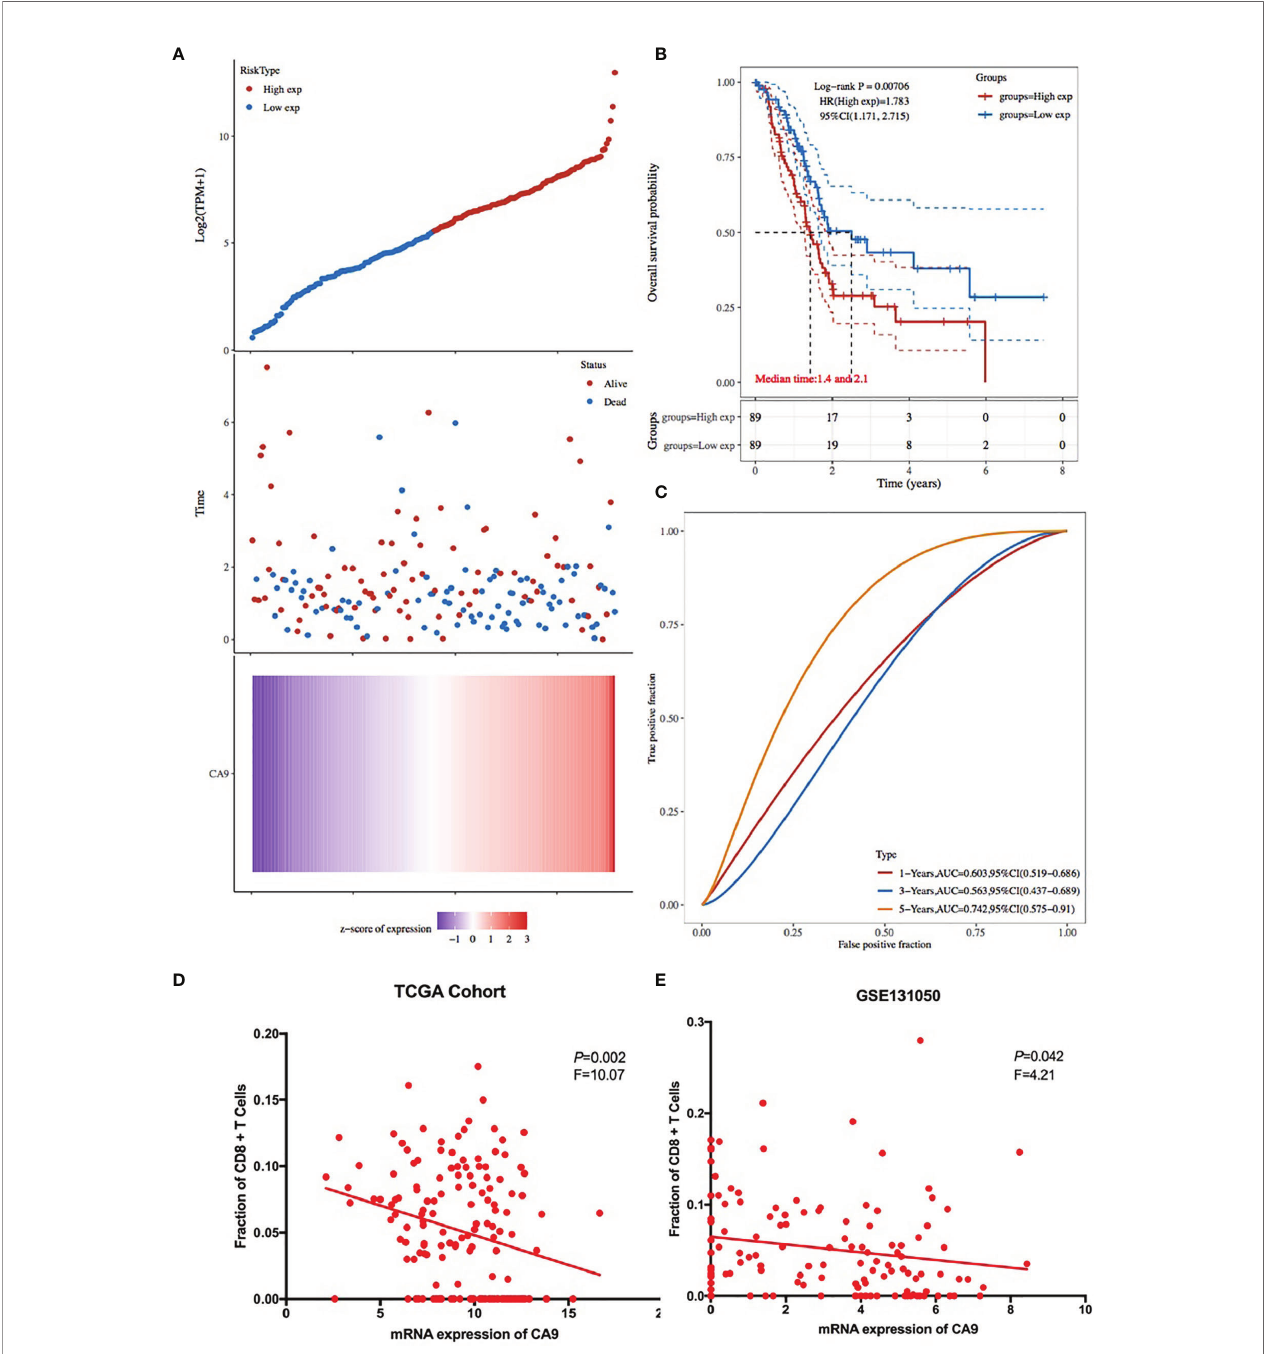
FIGURE 3 | Prognostic value of CA9 and its association with CD8+ T cells in fi ltration from TCGA and GEO pancreatic cancer dataset. (A) Risk score plot and heatmap of CA9 among TCGA pancreatic cancer patients. (B) Survival time and status for patients with high and low expression of CA9. (C) ROC analysis of overall survival for the CA9 gene signature in TCGA cohort. (D, E) . TCGA cohort data suggest that CD8+ T cell in fi ltration and CA9 expression are closely related, and GEO dataset GSE131050 con fi rms this